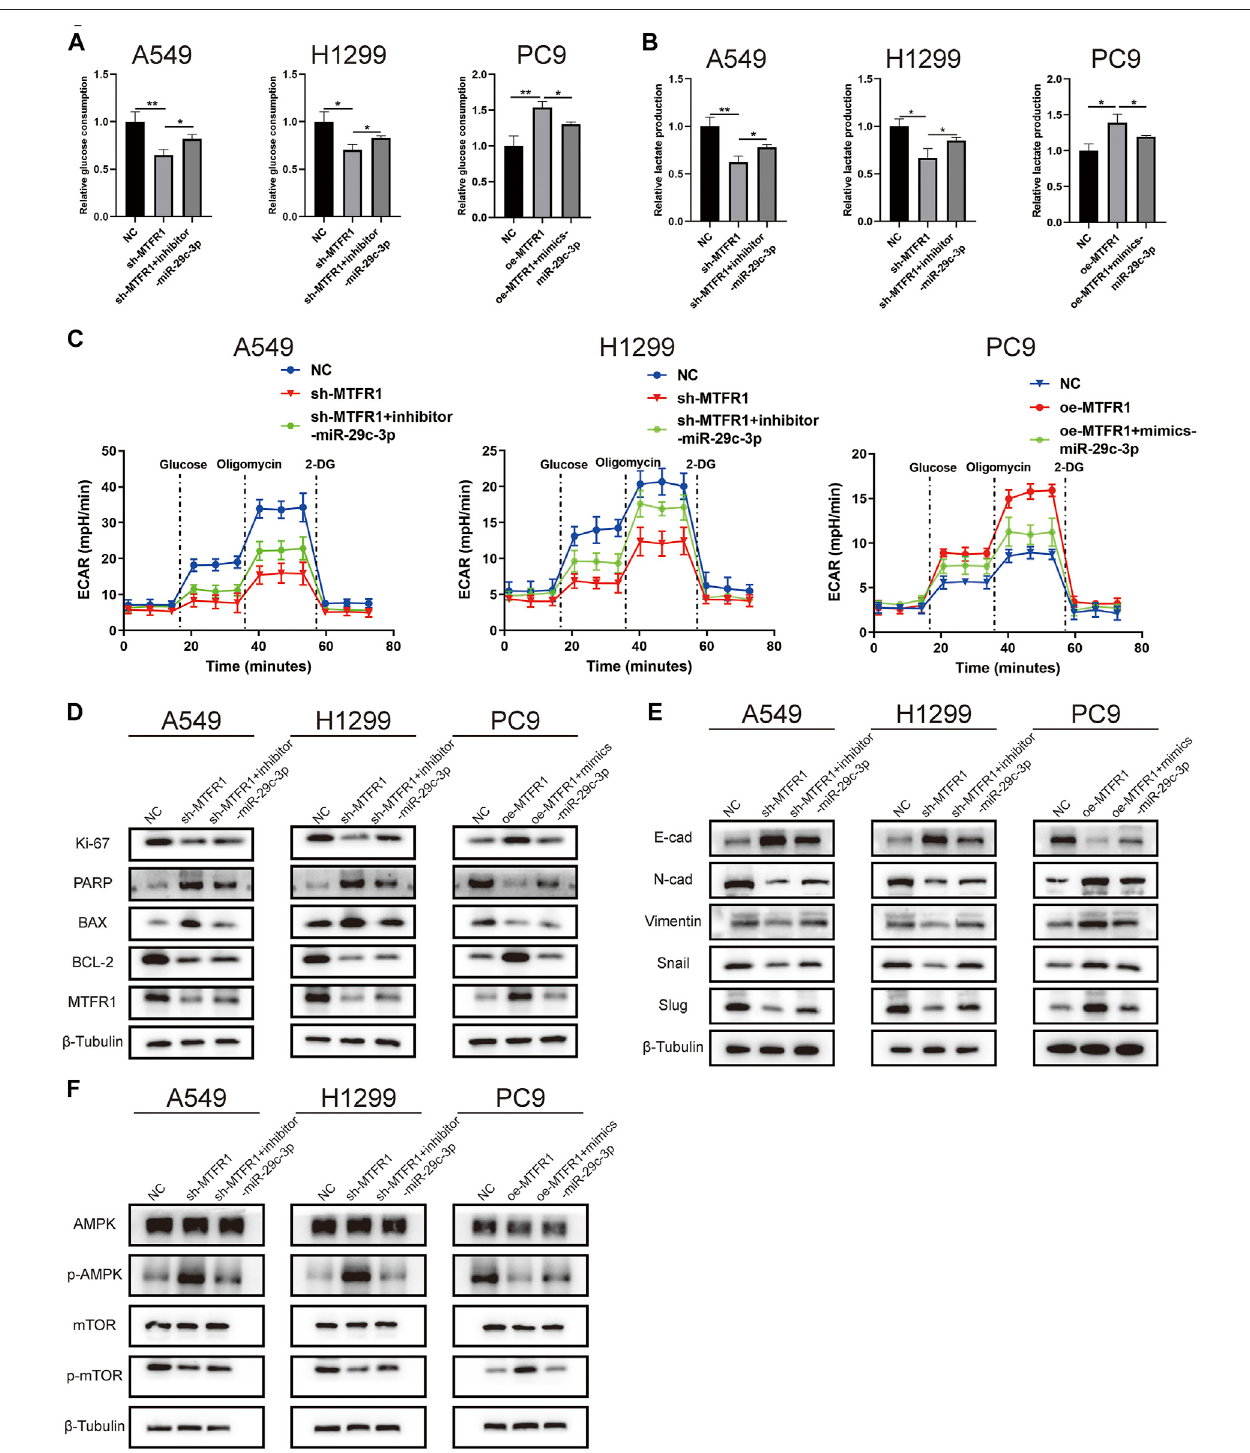
FIGURE 8 | miR-29c-3p could partly rescue the changes of glycolytic capacity and the expression of the phenotype-associated proteins caused by MTFR1 in LUADcells. (A – C) miR-29c-3pcouldrescuetheeffectofMTFR1ontheglycolyticcapacityofLUADcells. (D – F) miR-29c-3pcouldreverseMTFR1-inducedalterationsin theexpressionofproteinsassociatedwithcellproliferation,apoptosis,EMTandtheAMPK/mTORsignallingpathwayinLUADcells.Datawerearticulatedasthemean ± standard deviation (SD; * p < 0.05, ** p <